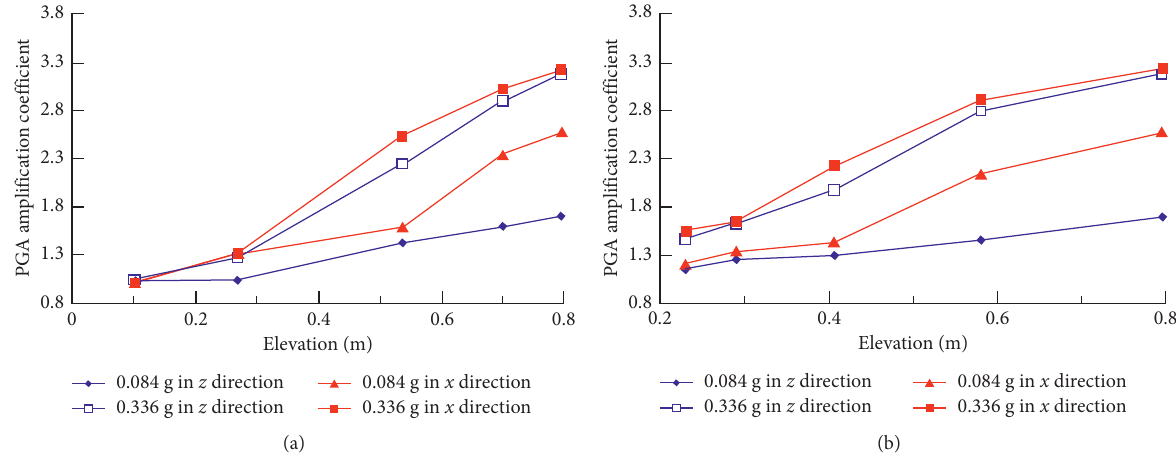
Figure 15: Acceleration amplification coefficient change rule of Lijiang slope: (a) inside the slope; (b) near the slope